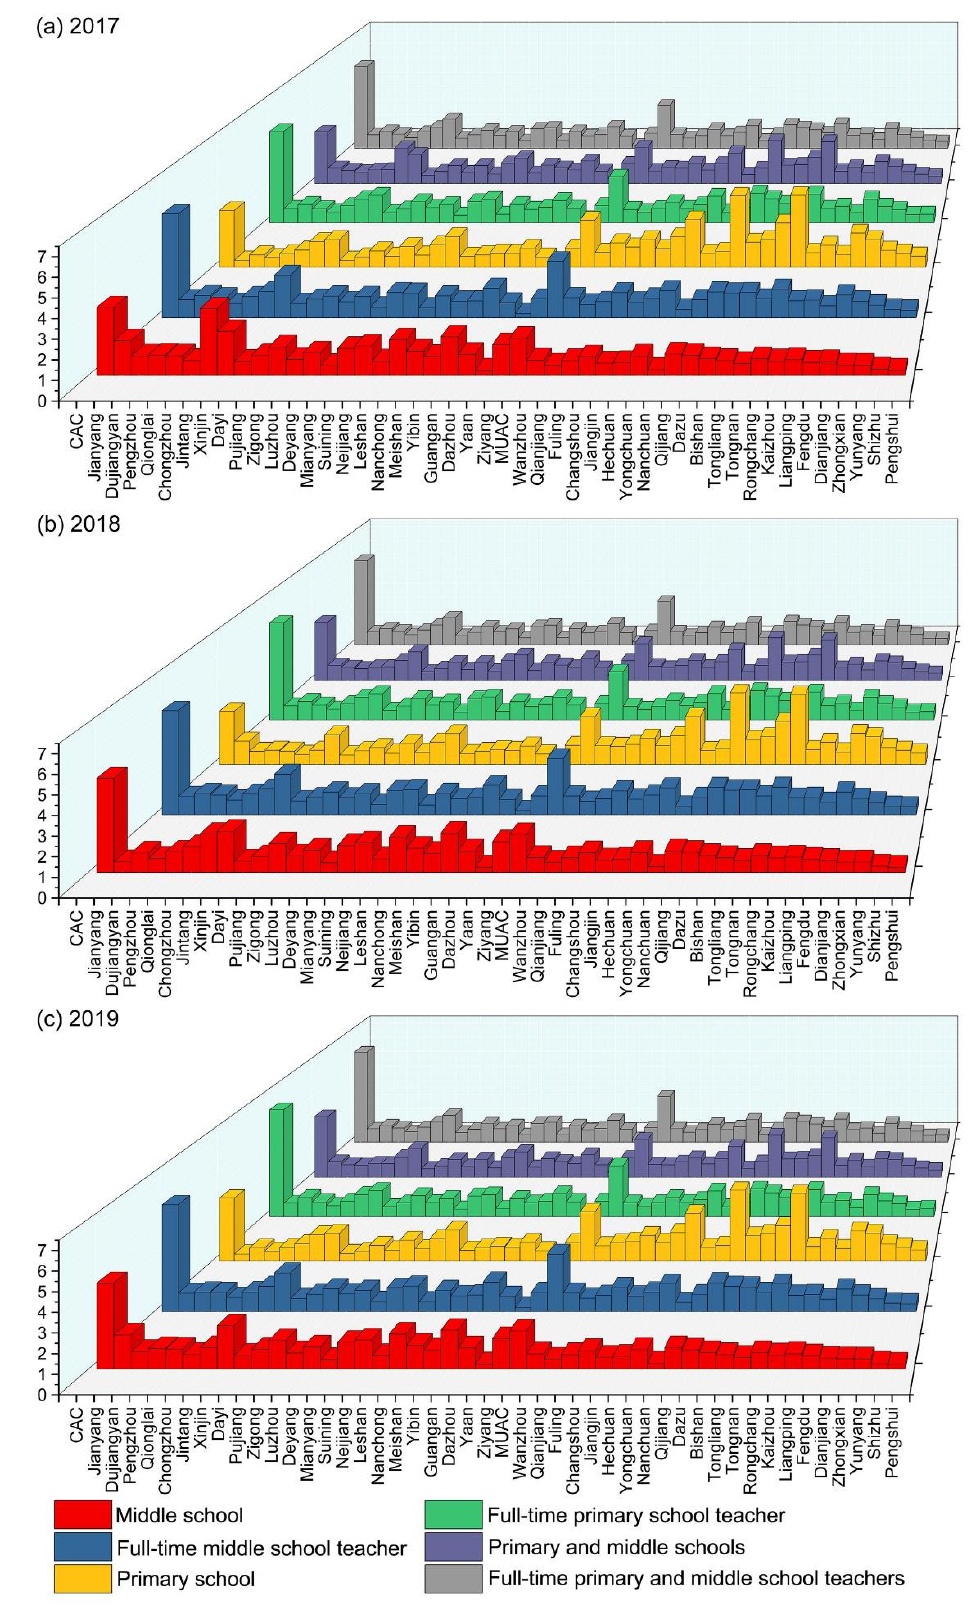
Figure 11. ERAD from 2017 to 2019.